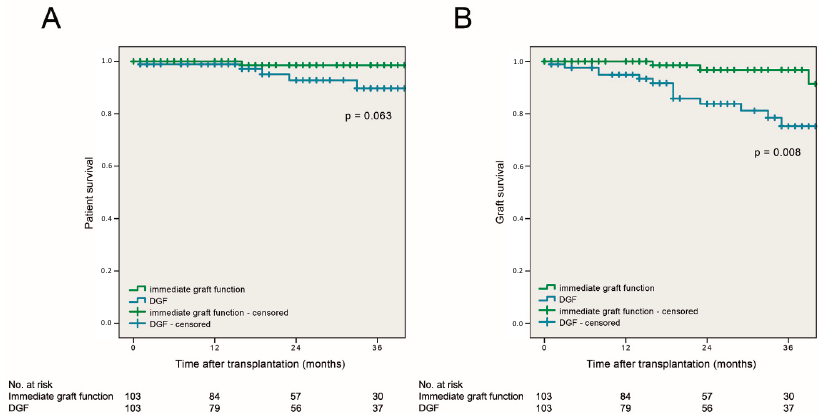
Figure 3. ( A ) Estimated 3-year patient and ( B ) 3-year graft survival rates after transplantation of HMP and SCS kidneys.